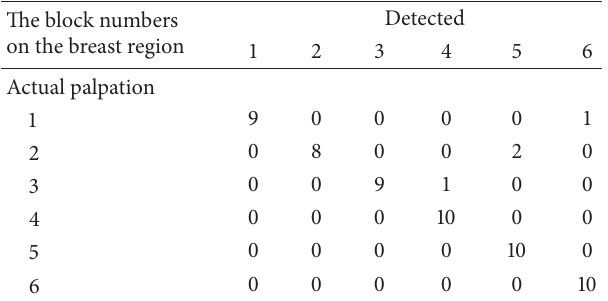
Table 10: The resultant confusion matrix for the integrated algo- rithm.